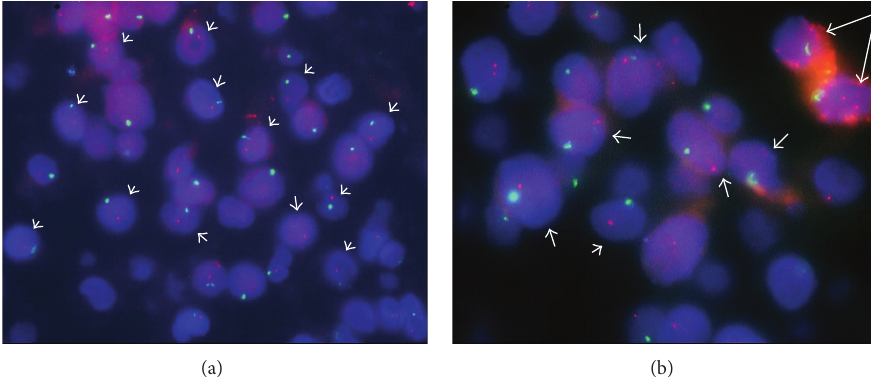
Figure 5: Double-colour FISH analysis of the tumour: loss of chromosome RB1 /13q14 region as indicated by the presence of single red signals from Spectrum-Orange labelled RB1 locus specific probe in reference to single green signals from Spectrum-Green labelled CEPX probe (short arrows). Representative tumour area under lower (a) and higher magnification (b). Long arrows on image (b) point to macrophages that show diploid RB1 copy number, as expected in normal cells (internal